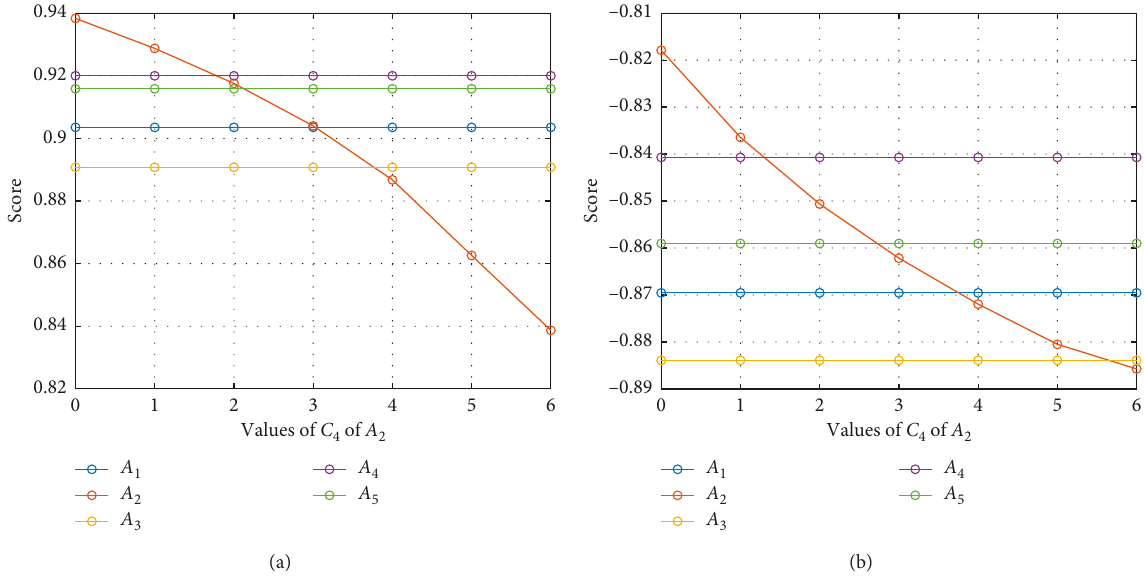
Figure 7: The change of the places of A 2 in the rankings of the group of WMSMs [47] and the group of WGMSMs [47]. Scores of the five companies computed by the group of (a) qROFWMSMs and (b)